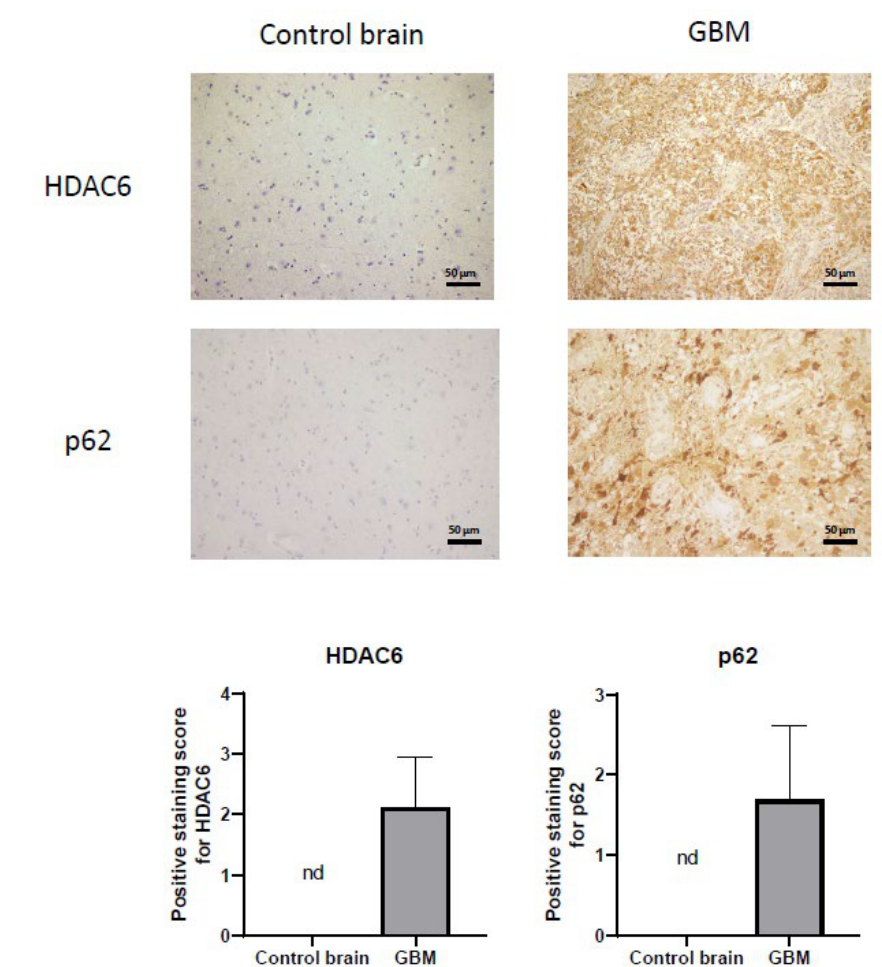
Figure 3. HDAC6 and autophagic marker p62 overexpression detected by immunohistochemistry in GBM samples. ( A ) Representative image of each protein and group. Every photograph has been taken at 20 × . ( B ) Analysis of positive staining score of each sample. Data are represented as mean ± SD (control brain tissue: n = 10, GBM: n = 40). nd: not